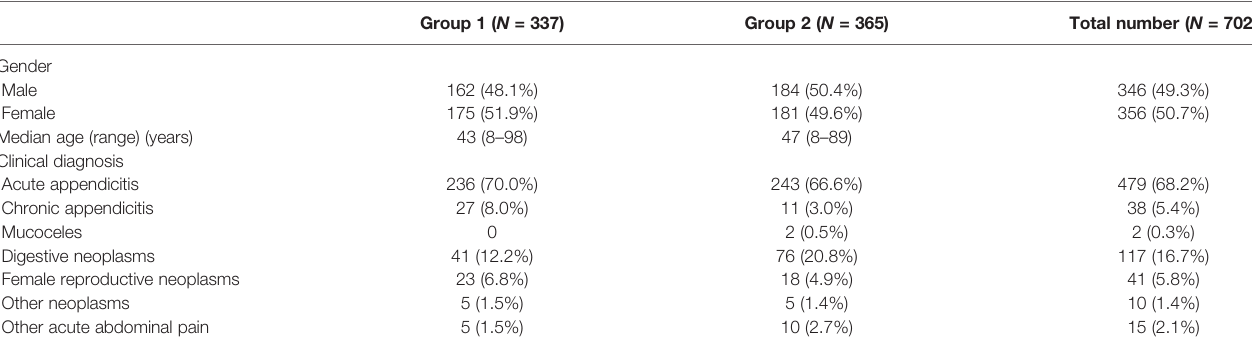
TABLE 1 | Clinical features between different appendix submission